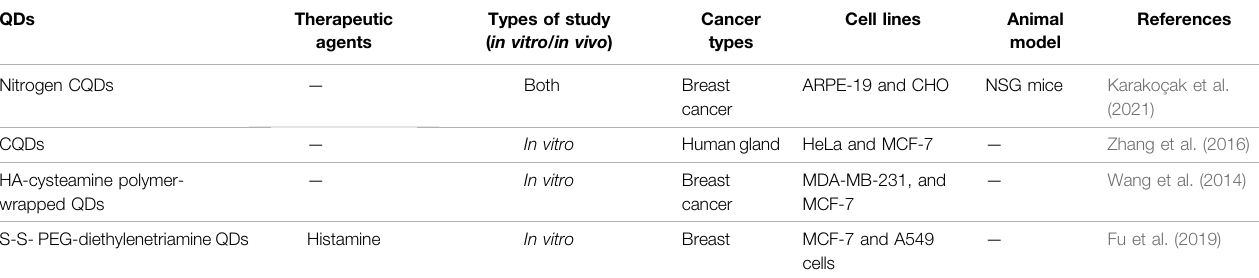
TABLE 7 | Illustration of quantum dot-targeted CD44 cells.